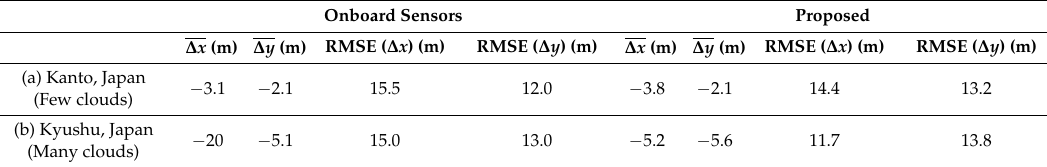
Figure 6. Examples of map-projected ASTER images and their zoom-in images based on sensor attitude deduced from proposed method for scenes with ( a ) few clouds and ( b ) many clouds. Table 3. Mean miss-registration errors and RMSEs of matched feature pairs extracted from projected ASTER and OLI images. The projection was examined based on sensor attitude from onboard sensors and proposed method for comparison. Symbols ∆ x and ∆ y represent east–west and north–south directions, respectively.